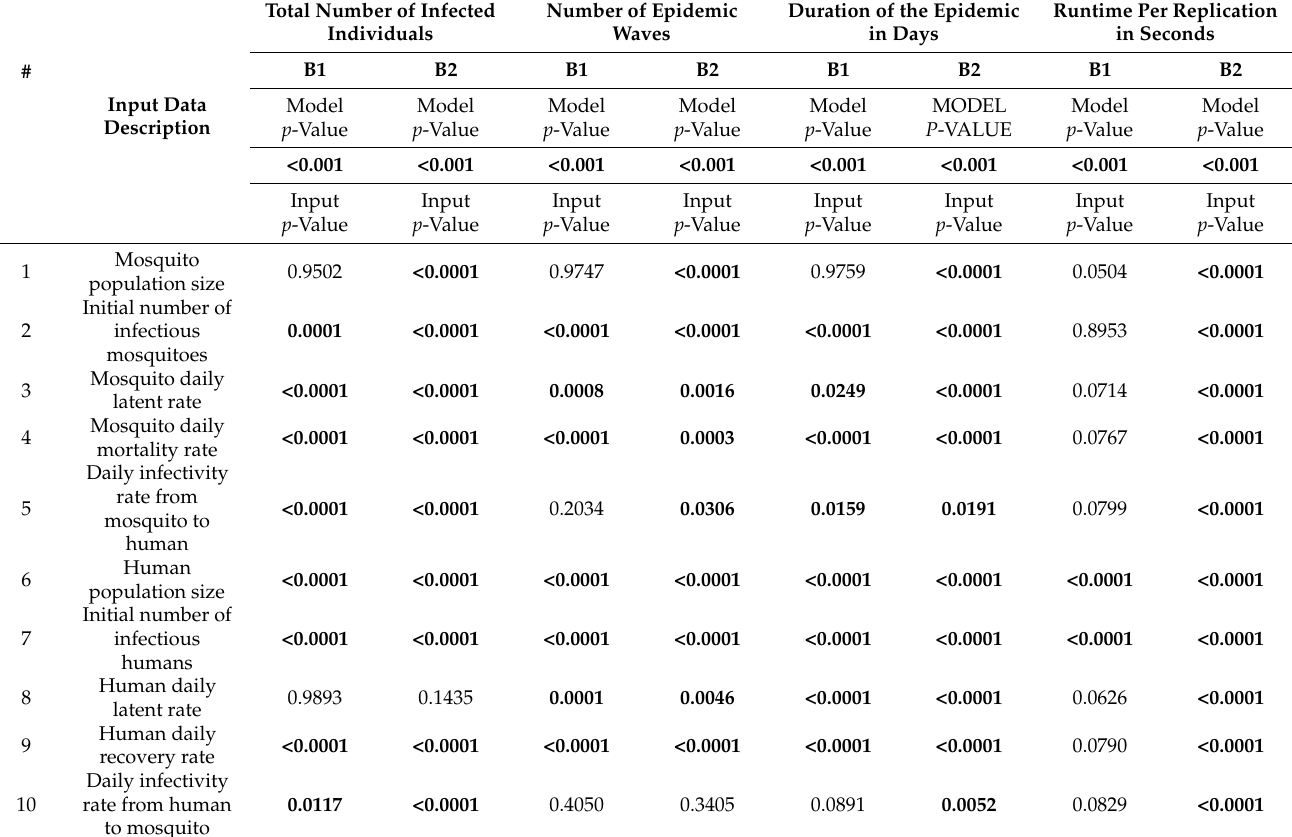
Table 9. ANOVA results for Model B (data quality) per baseline level. Bold font denotes statistical significance at α -level of 0.05.